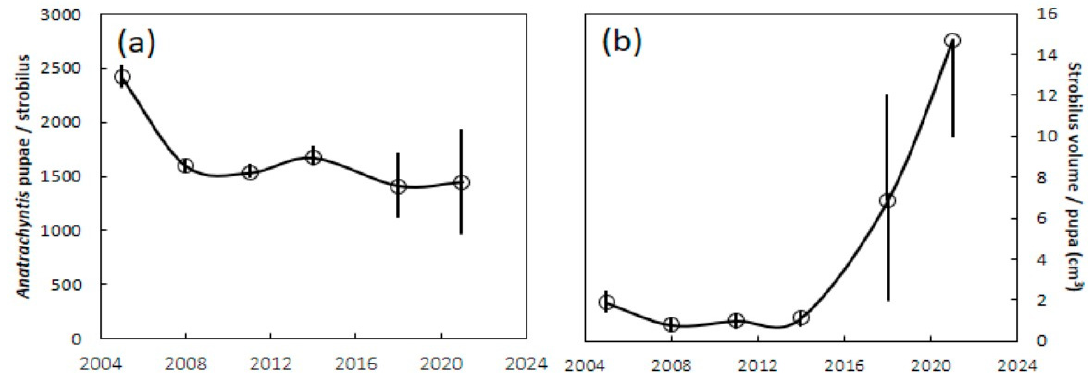
Figure 3. The number of Anatrachyntis pupae in Cycas micronesica microstrobili in Guam karst forest from 2005 to 2021. ( a ) Pupae per strobilus; ( b ) strobilus volume per pupa. Mean ± SE, n = 6.